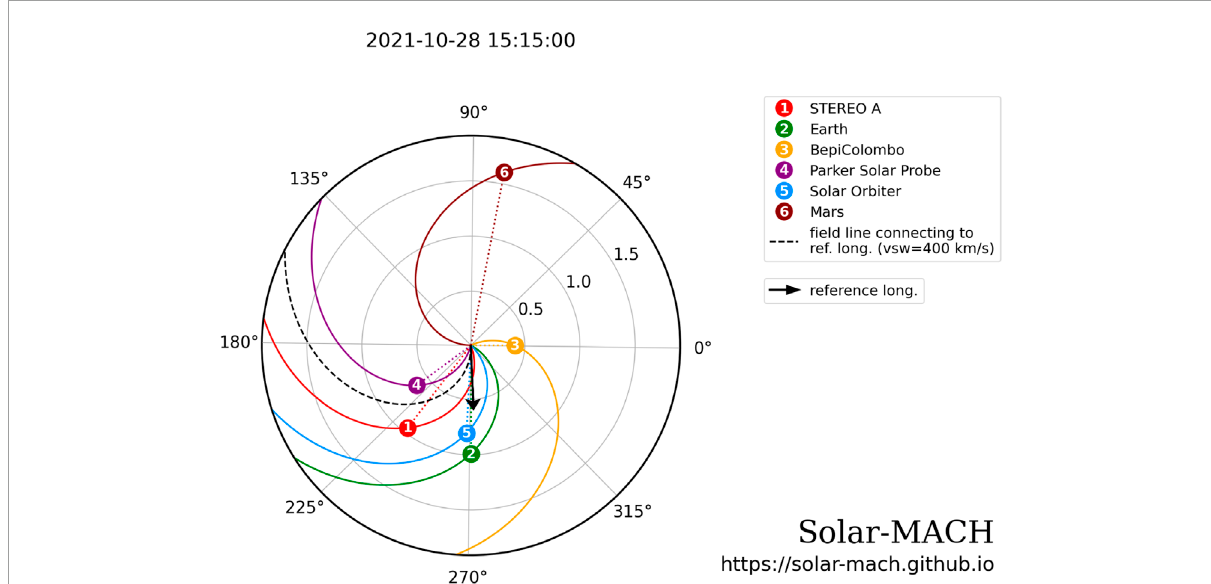
FIGURE 1 Solar-MACH plot for the time of the ground-level enhancement (GLE) event on 28 October 2021. Numbered symbols indicate the observers’ locations and the spiral lines corresponding HMF lines connecting them to the Sun. Radial distance is provided in astronomical units (AU), and the angular information is given in Carrington longitude. The arrow points out the freely choosable location of a “reference” (e.g., a solar flare) at the Sun, and the dashed spiral line indicates a corresponding HMF line originating at that